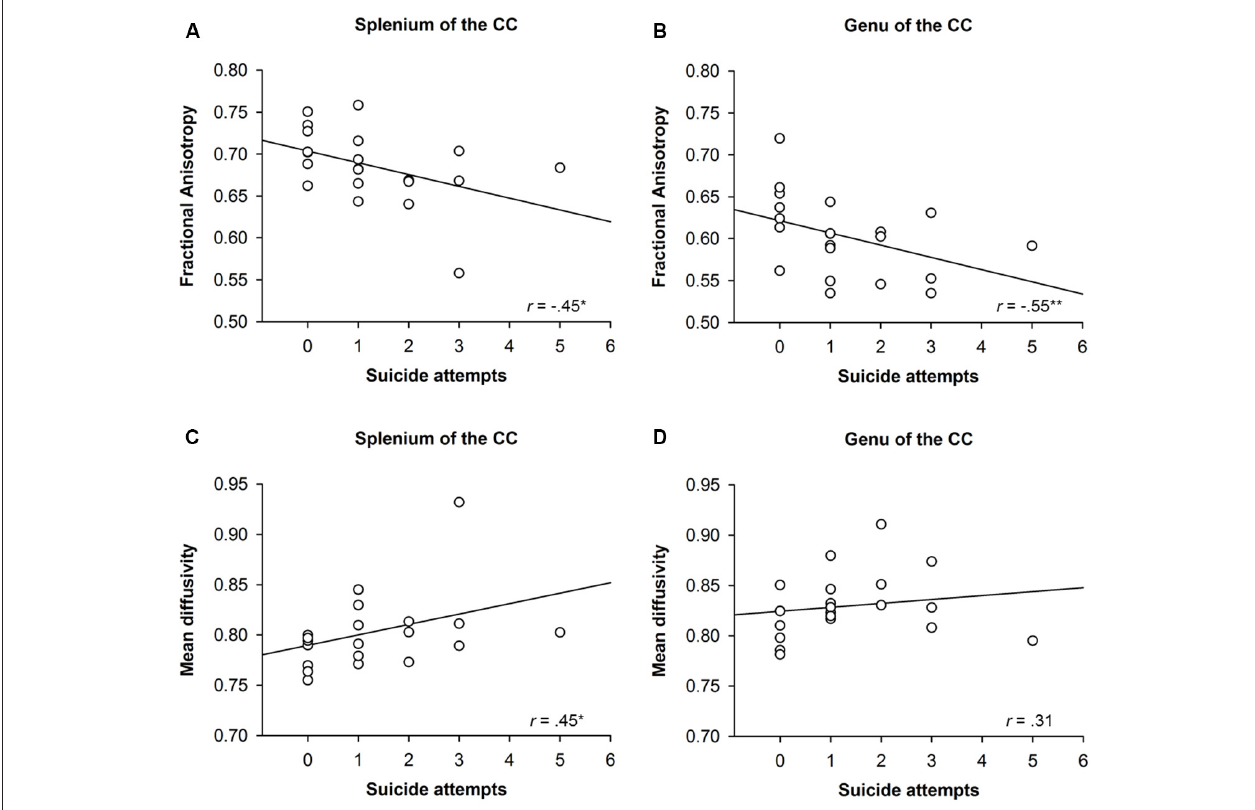
FIGURE 3 | Correlation between structural alterations in distinct regions of the Corpus Callosum (CC) and suicidal behavior of participants with borderline personality disorder (BPD). The upper panels (A,B) show the correlation between suicidal attempts and fractional anisotropy (FA) in the splenium and genu of the CC, whereas the lower panels (C,D) show the correlation between suicide attempts and mean diffusivity (MD) in the splenium and genu of the CC. ∗ p < 0.05, ∗∗ p < 0.01.